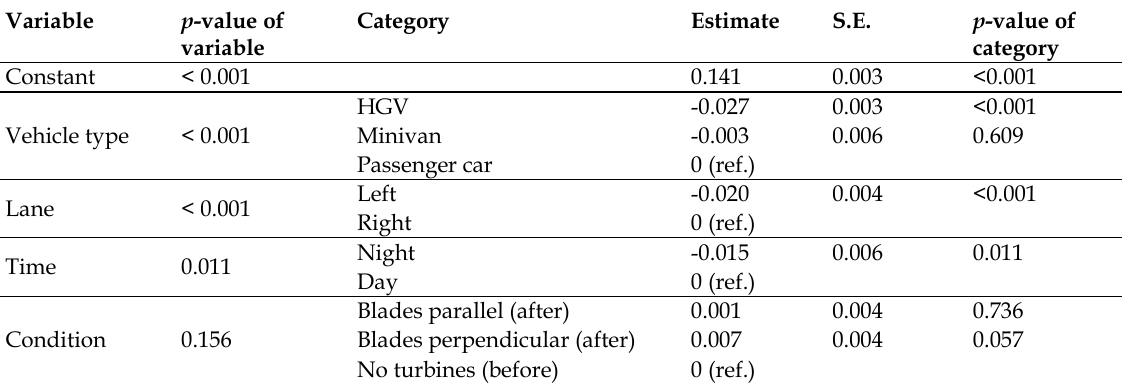
Table 3. Regression model standard deviation of lateral